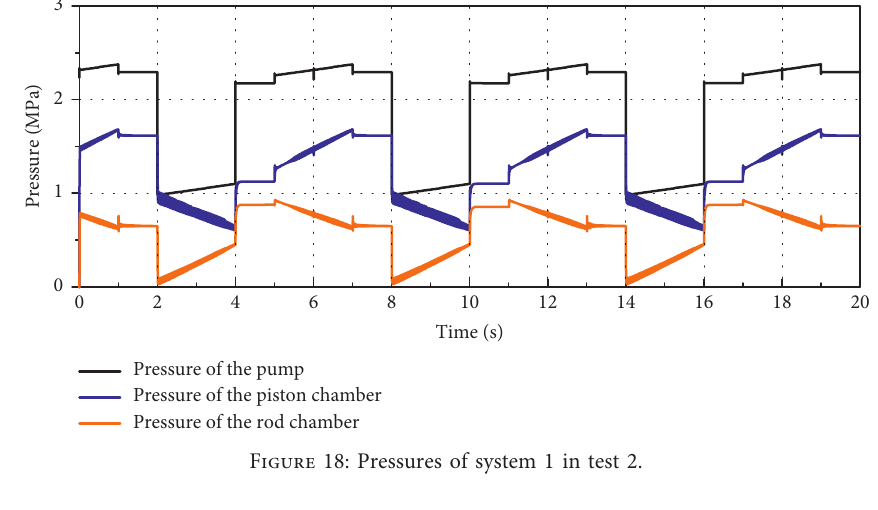
Figure 18: Pressures of system 1 in test 2.